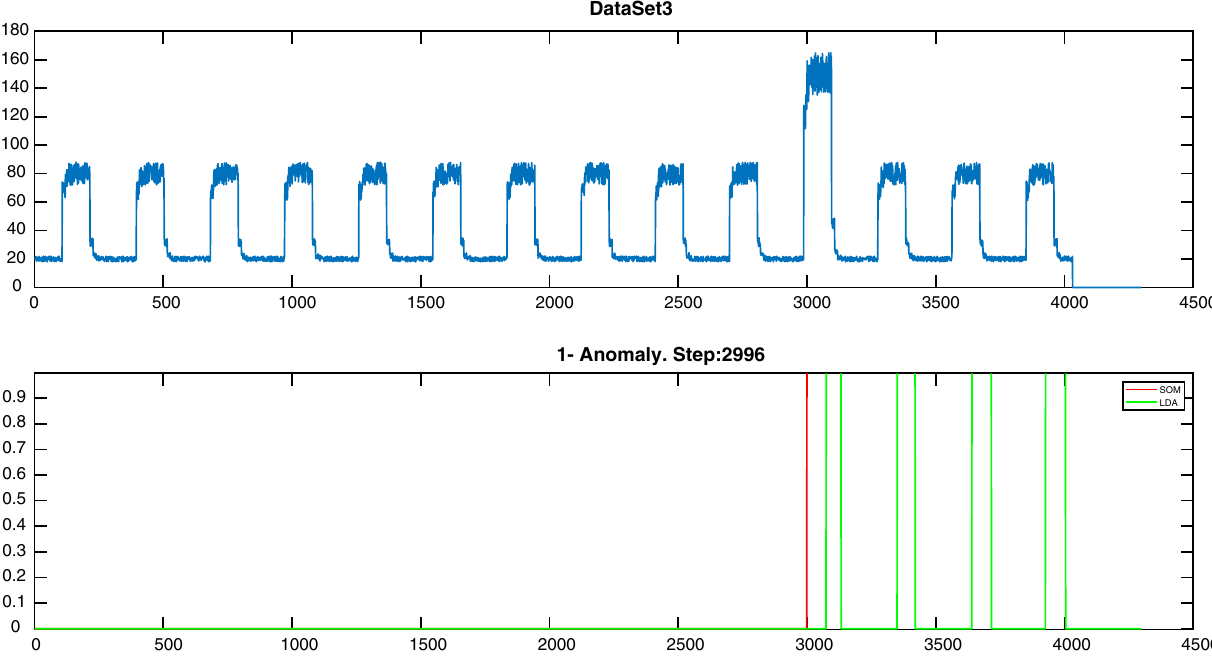
Fig. 9 Anomaly detection (art_daily_jumpsup.csv) using proposed